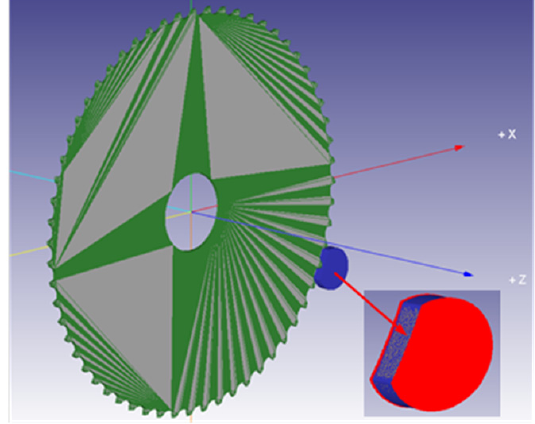
Figure 8. Constraints of saw blade and workpiece.